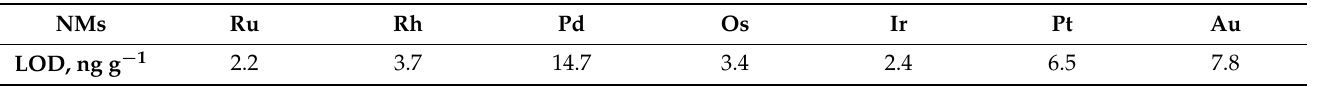
Table 7. Limits of detection (3 σ ) of NMs in ng g − 1 in initial geological sample. NMs Ru